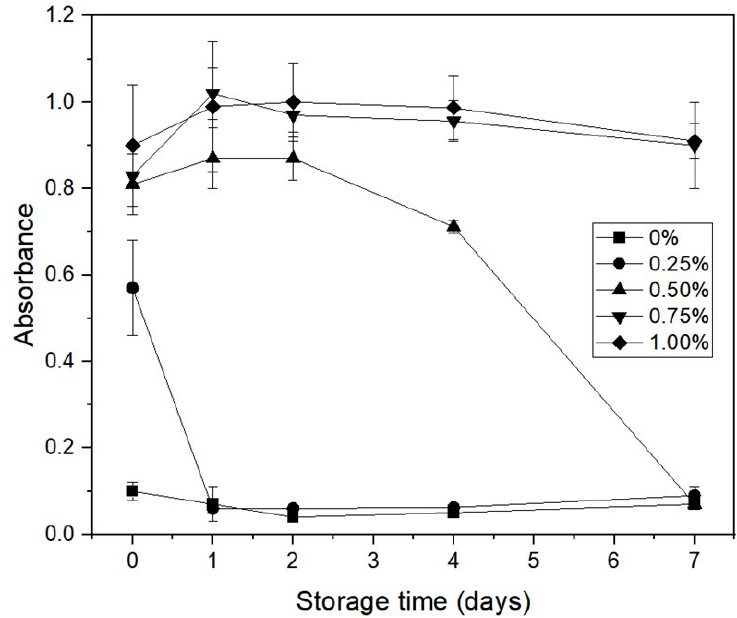
Figure 3. Spectroturbidity of O/W emulsions containing different concentrations of C. olitorius mucilage during seven days of storage.